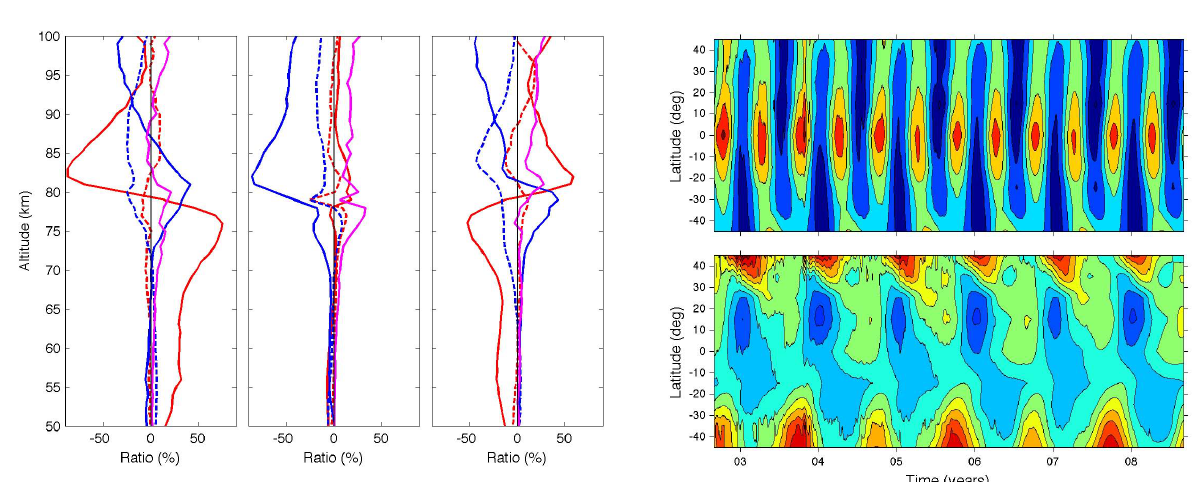
Fig. 14. The daily vertical partial ozone columns as a function of time and latitude. The columns are calculated from the time se- ries. The upper panel gives the partial column in 80–100km and the lower panel the partial column in 15–100km. The unit in both figures is Dobson unit (2 . 69 × 10 16 moleculescm − 2